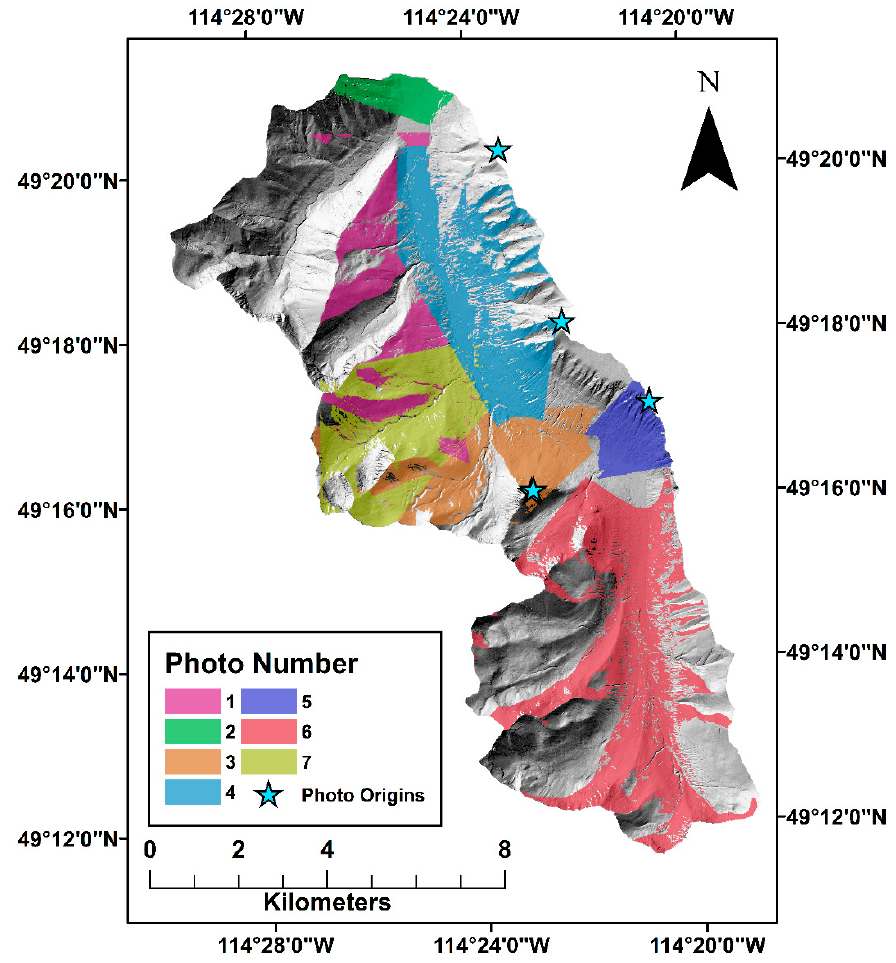
Figure 2. Visible region of WCW in each of the seven MLP photographs. In cases where the same region is visible in multiple photographs, the photograph used for analysis was determined by criteria described in [49] .